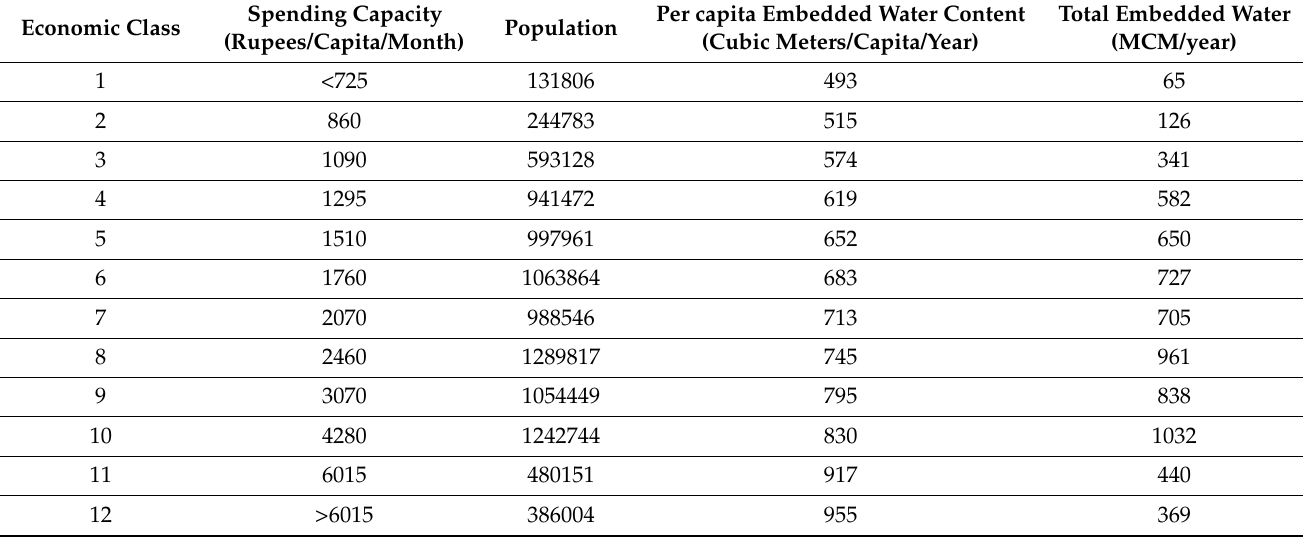
Table 2. Details of spending capacity, population, per capita embedded water, and total embedded water for all twelve economic